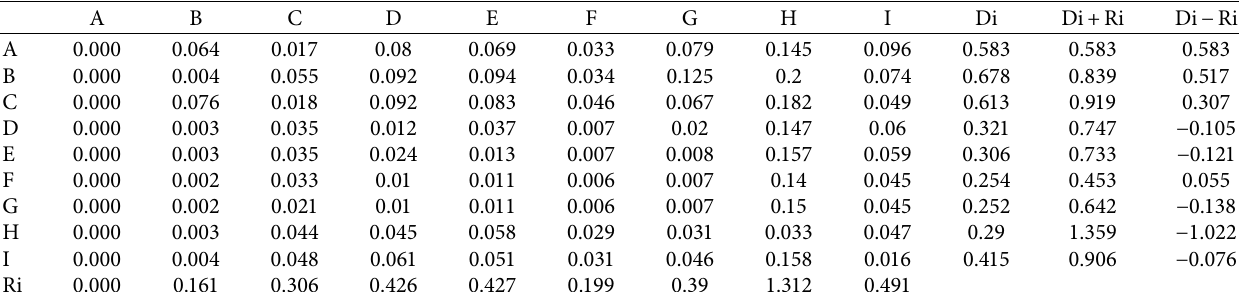
Table 18: The comprehensive influence matrix after influence.